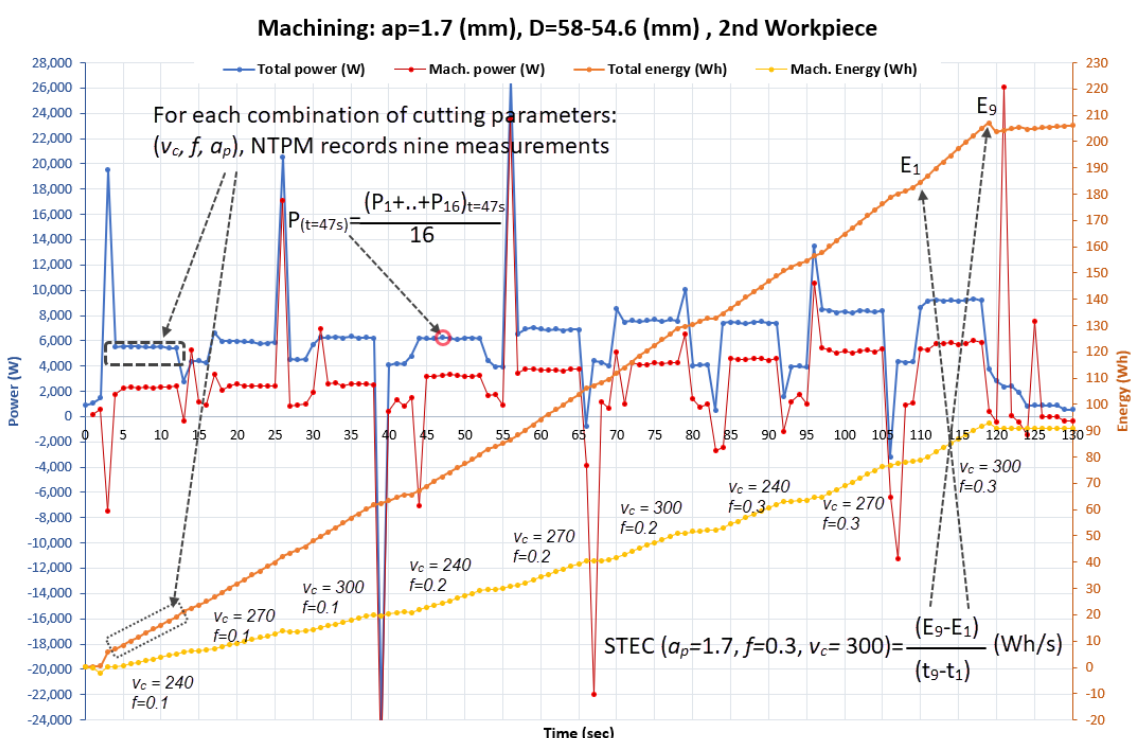
Figure 6. Recording energy consumption and engaged power measurements was done at discrete